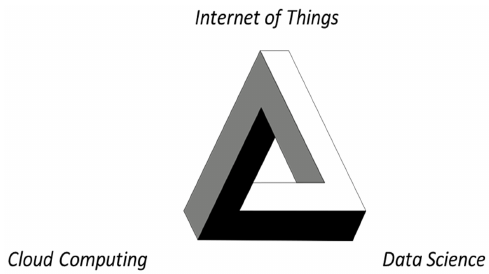
Figure 19. The complementarity of IoT, cloud, and data science is a key field of future work for integrative research efforts each needing to understand the role and capabilities of the